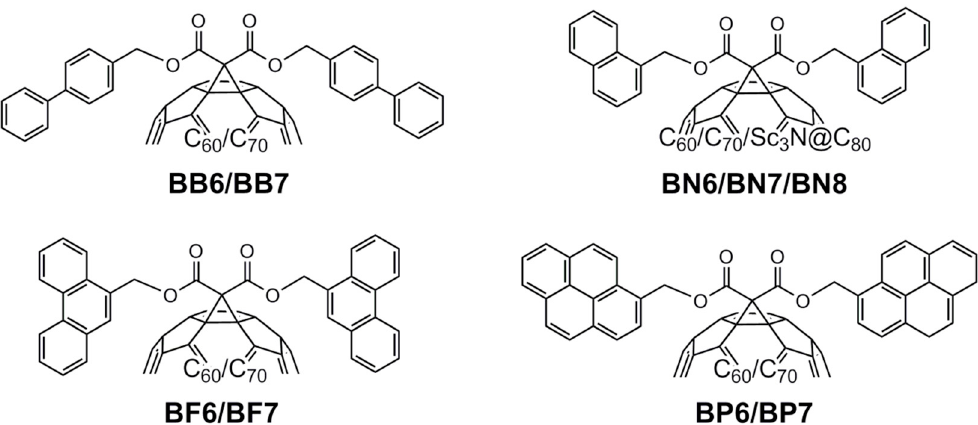
Figure 2. Structures of synthesized fullerene malonates.